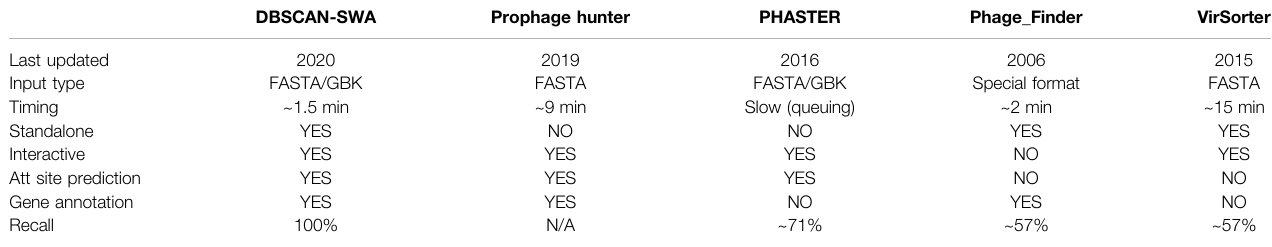
TABLE 1 | Performance comparison of DBSCAN-SWA with other prophage detection tools on Xylella fastidiosa Temecula1genome sequence (NC_004556). DBSCAN-SWA Prophage hunter PHASTER Phage_Finder VirSorter